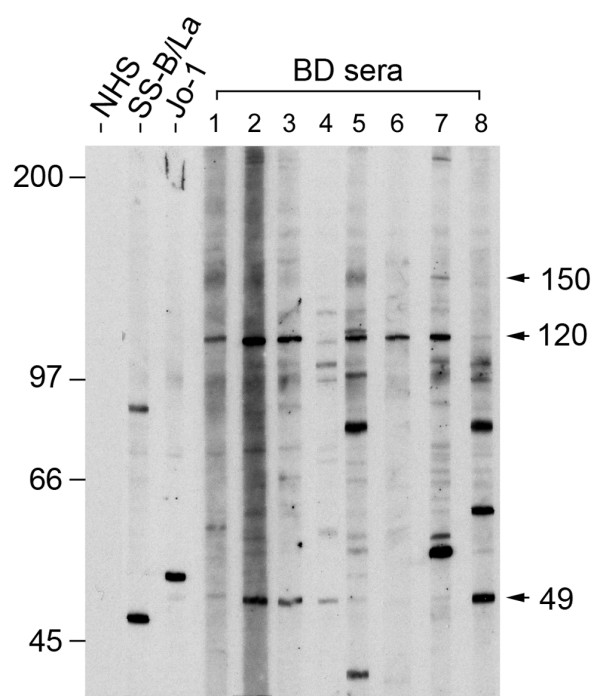
Western blot analysis of autoantibodies in selected BD sera. Whole cell extracts from bovine aortic endothelial cells were separated by a 7.5% gel SDS-PAGE, transferred to nitrocellulose and probed with serum dilutions of 1:100. Several sera showed reactivity to proteins of 49, 120 and 150 kDa. The serum in lane 2 with the strongest reactivity to the 49 kDa and 120 kDa bands was selected as the probe for the expression library screening. Molecular mass markers are shown on the left. NHS represents the normal control. BD, Behçet's disease.